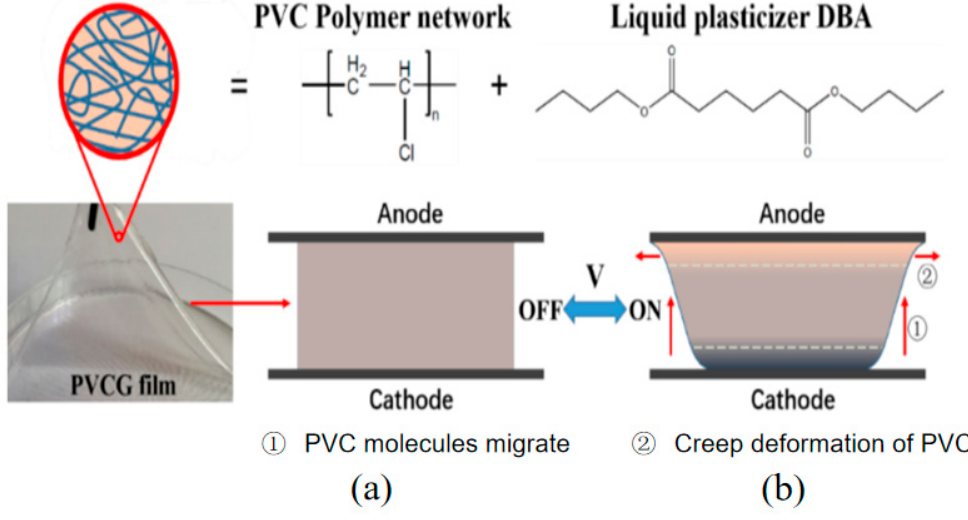
Figure 1. Deformation principle of PVC-gel actuator. ( a ) Discharge ( b ) Charge. The PVC-gel actuators in application include the traditional mesh anode-planar PVC gel-planar cathode structure (referred to as the planar PVC gel actuator) [5,24] and, more recently, the planar electrode-corrugated PVC gel structure (referred to as the corrugated PVC gel actuator) [20,28]. For any of the structures, the basic actuating unit is the sandwich structure as electrode layer–core layer–electrode layer. A key common feature of the two typical actuators is the existence of pore structures, which are necessary for the actuators to deform effectively; for example, the migration of the peak material to the valley floor or the transfer of planar materials into the mesh pores.